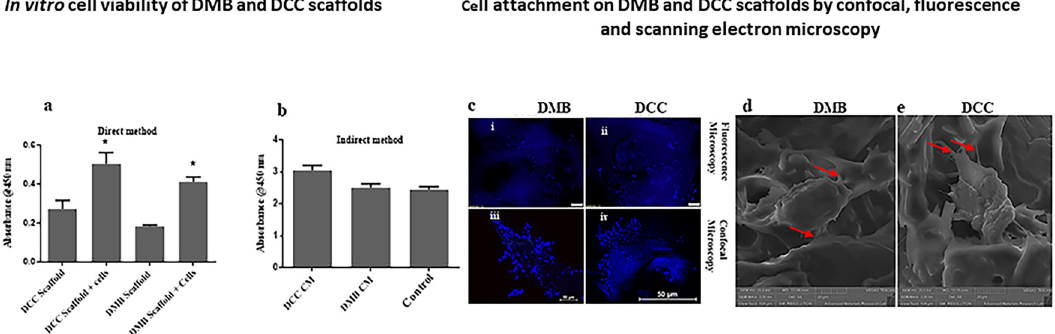
Fig 8. Cell viability studies employing DMB and DCC scaffolds. Bar charts indicate comparison between DCC scaffold vs DCC scaffold + cells and DMB scaffolds vs DMB scaffold + cells by direct method (a). Bar charts indicate comparison between DMB conditioned media (CM) and DCC conditioned media (CM) vs complete culture media (Control) by indirect method (b). * p < 0.05 is indicated. n = 4; CM: conditioned media. (c). HOB cells seeded on DMB and DCC scaffolds showing optimum cell attachment by DAPI staining. (i & iii) DMB scaffolds and (ii & iv) DCC scaffolds; images were captured by fluorescence and confocal microscopy, respectively. Scanning electron micrograph of HOB cells seeded onto DMB (d) and DCC (e) scaffolds. The osteoblast shows a healthy morphology residing on the ECM with evidence of filopodia spread (red